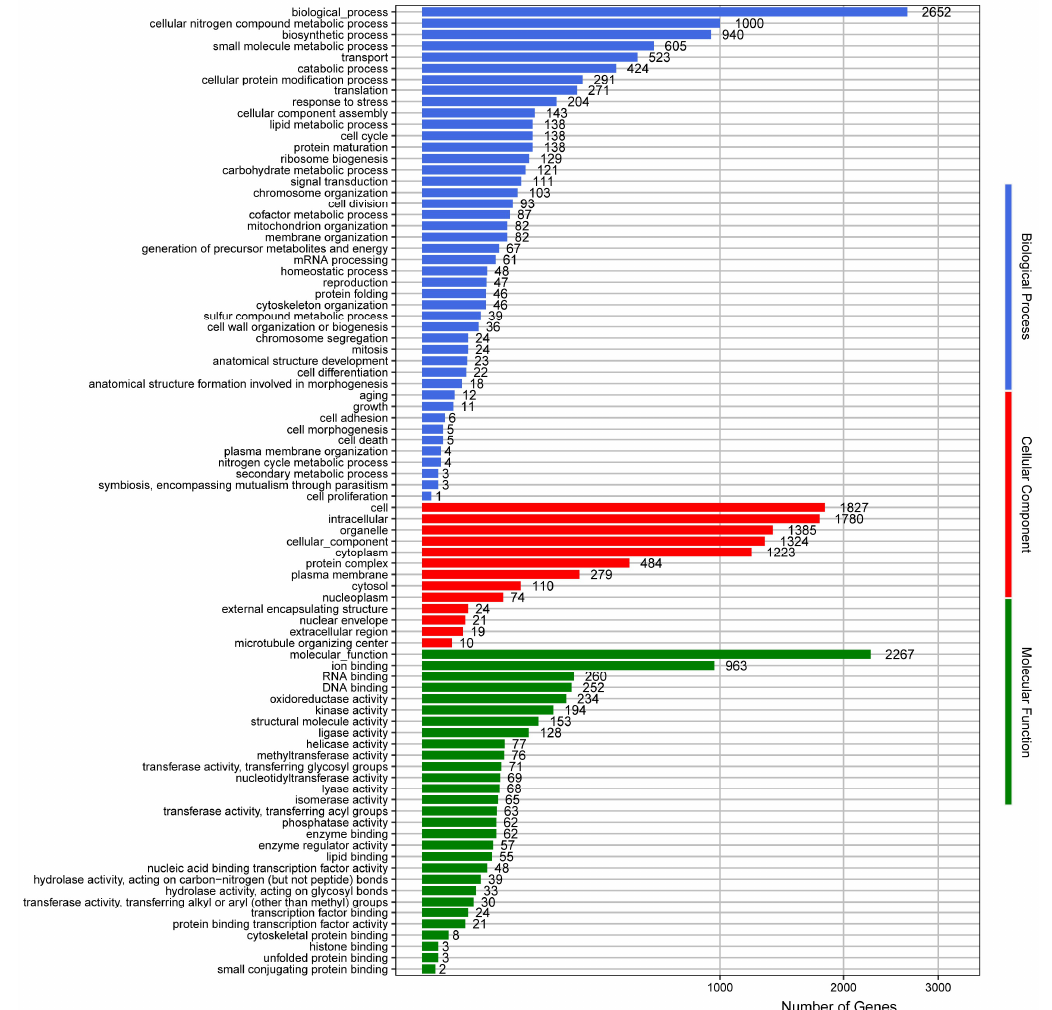
Figure 5. GO annotation of S. bacillaris CC-PT4 genome. Table 2. CAZy analysis